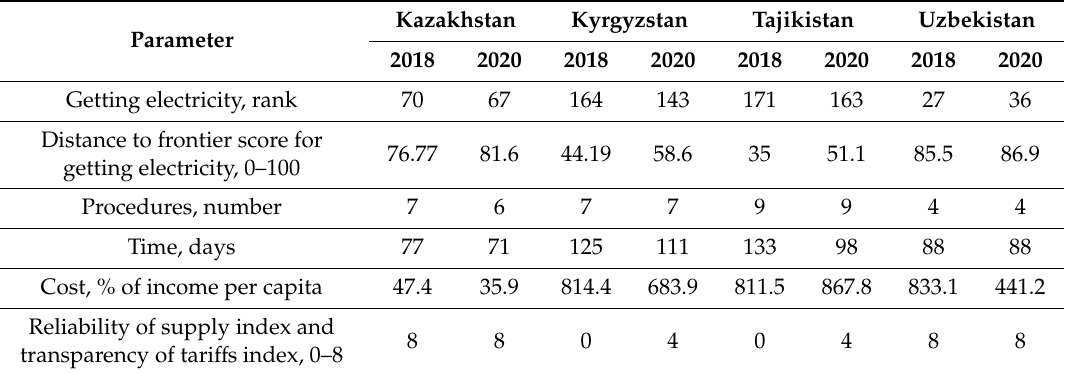
Table 13. Getting Access to Electricity (Source: Doing Business 2018. Reforming to Create Jobs. World Bank Group, 2018, pp. 170, 172, 198, 203; and Doing Business 2020. Country Profile (for each respective country); World Bank Group,